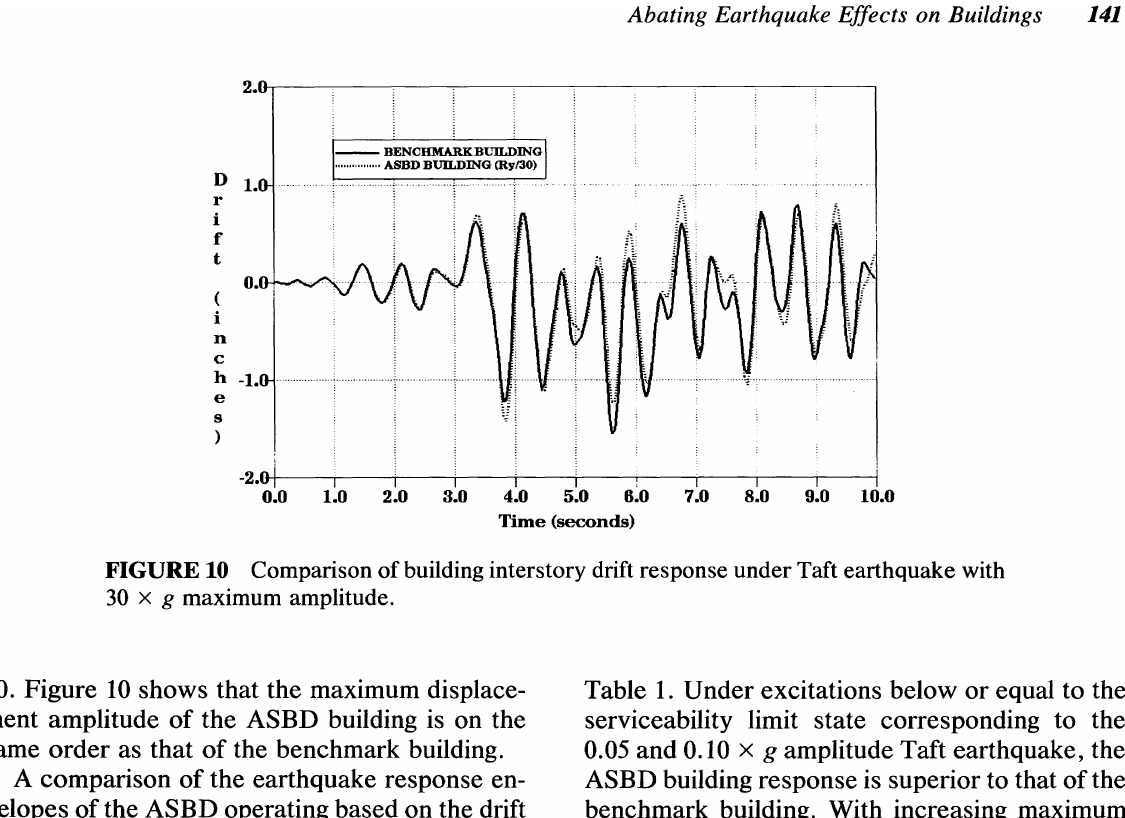
FIGURE 10 Comparison of building inters tory drift response under Taft earthquake with 30 x g maximum amplitude.